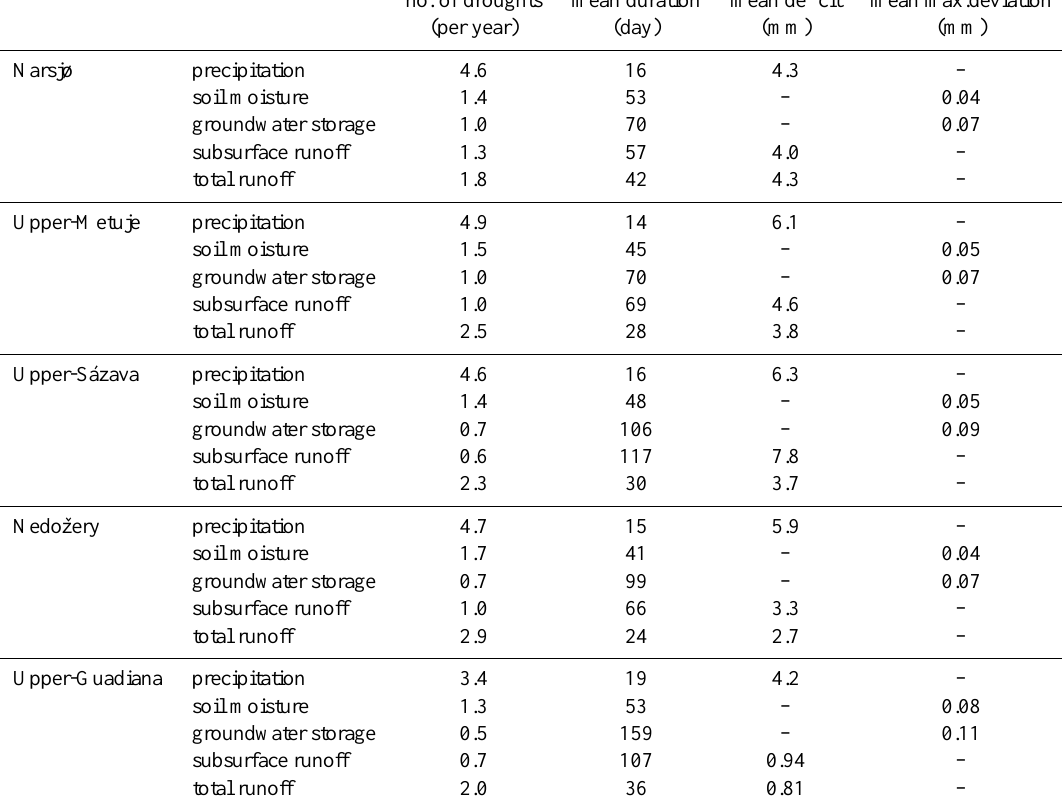
Table 4. General drought characteristics using a 80% monthly threshold (moving average 30days) and a minimum drought duration of 3days for the hydrometeorological variables derived from WFD and simulated with the large-scale models for all selected case study